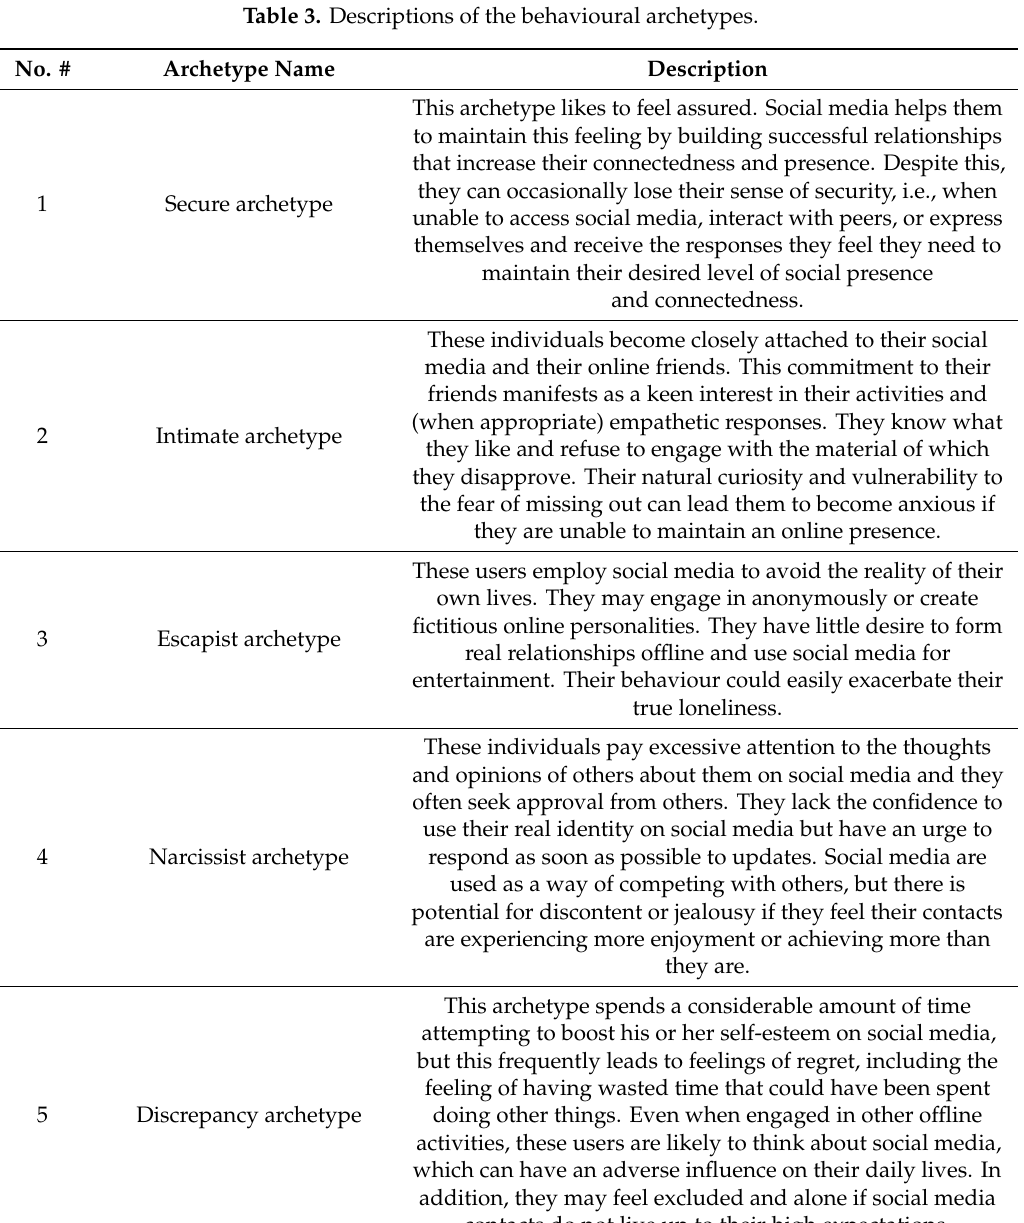
Table 3. Descriptions of the behavioural